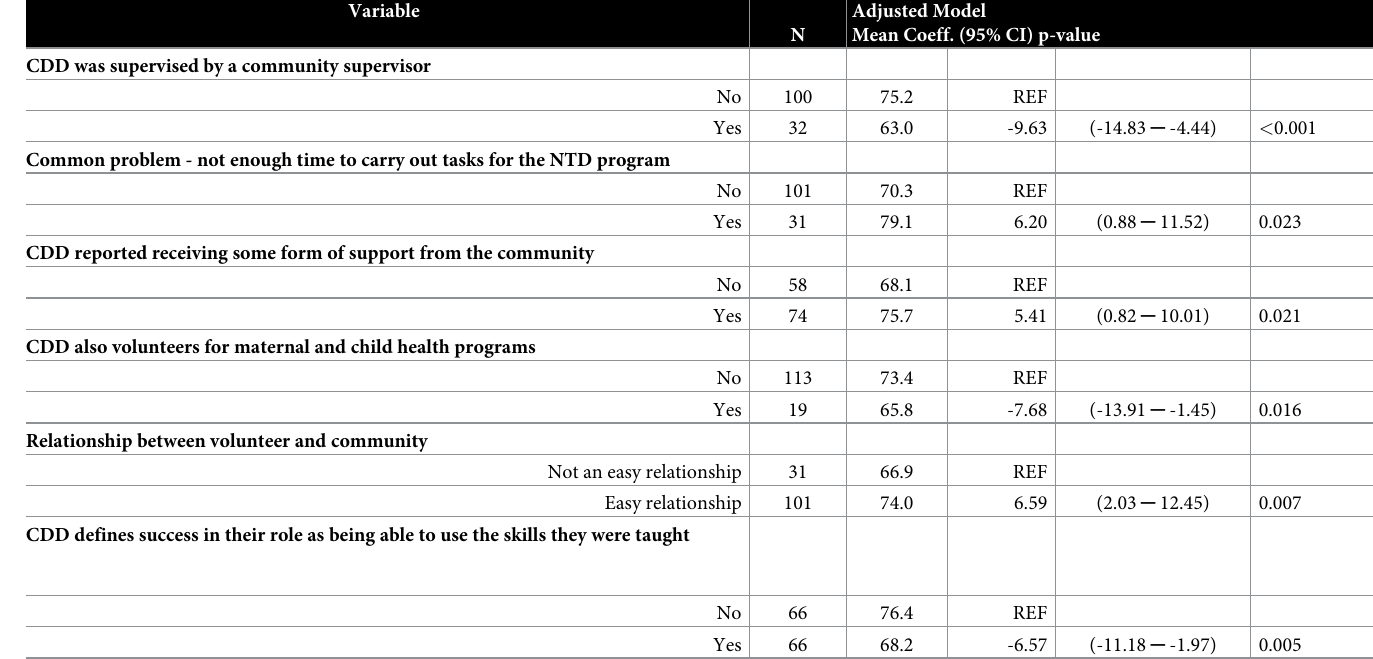
Table 11. Correlates of CD-RISC-25 scores for CDDs volunteering in MDA programs in Coˆte d’Ivoire.